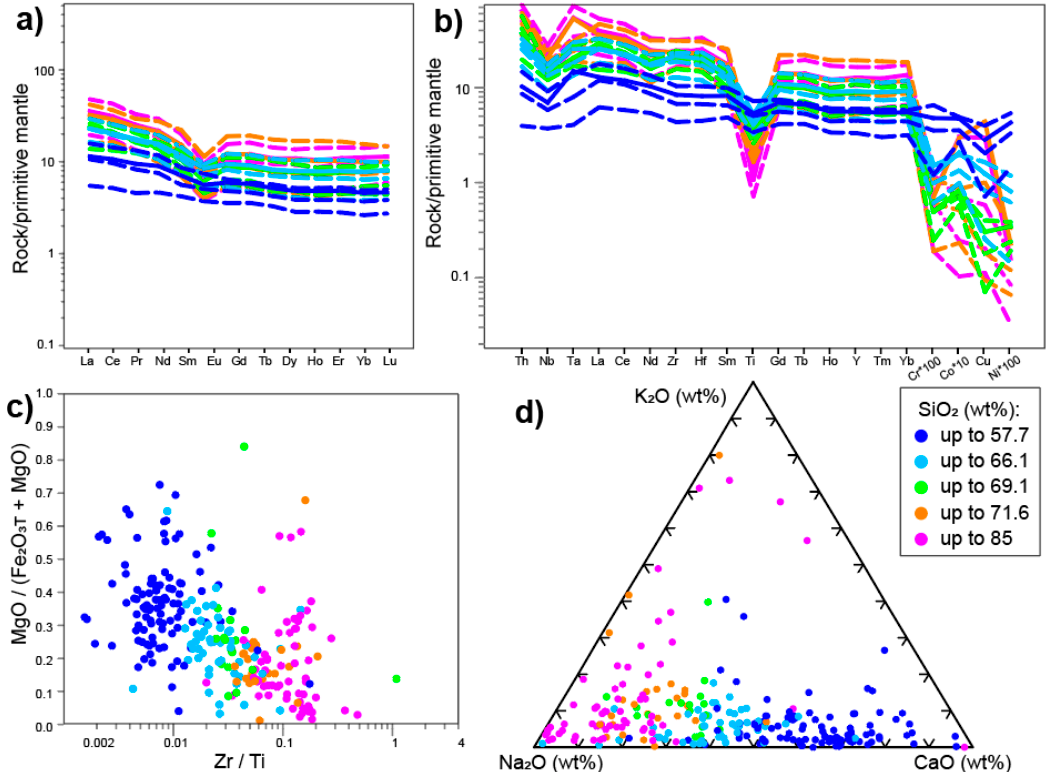
Figure 6. Chemical composition of intermediate-felsic intrusive rocks of the Sigeom dataset with (La / Yb) N < 6 ( n = 252). Rocks are displayed on ( a ) a primitive mantle-normalized [33] REE plot, ( b ) a primitive-mantle normalized [31] multi-element arachnid diagram modified from Pearce [35], ( c ) a binary plot of Mg number vs. Zr/Ti, and ( d ) a Na 2 O-K 2 O-CaO (in wt%) ternary diagram. In plots ( a ) and ( b ), mean values are displayed as solid lines, and the 25th, 50th (median), and 75th percentiles are displayed as dashed lines. Table 1. Rock types with fractionated ( ( La/Yb) N > 6) and less fractionated ((La/Yb) N < 6) REE profiles.